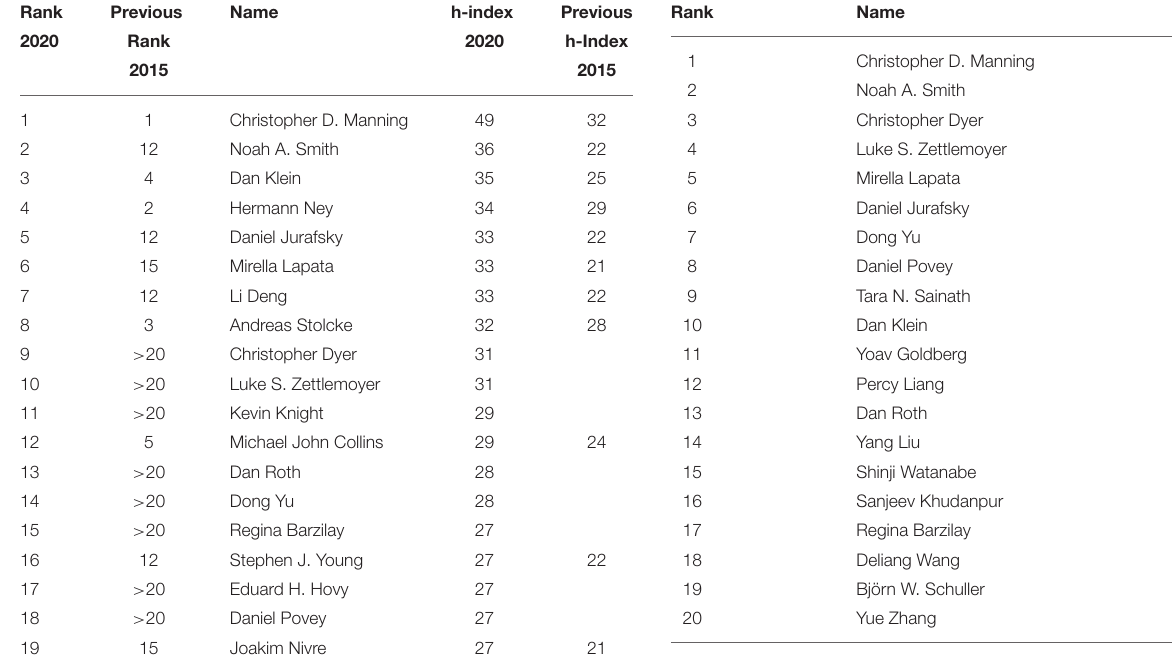
TABLE 16 | List of the 20 authors with the largest h-index up to 2020 in comparison with 2015.